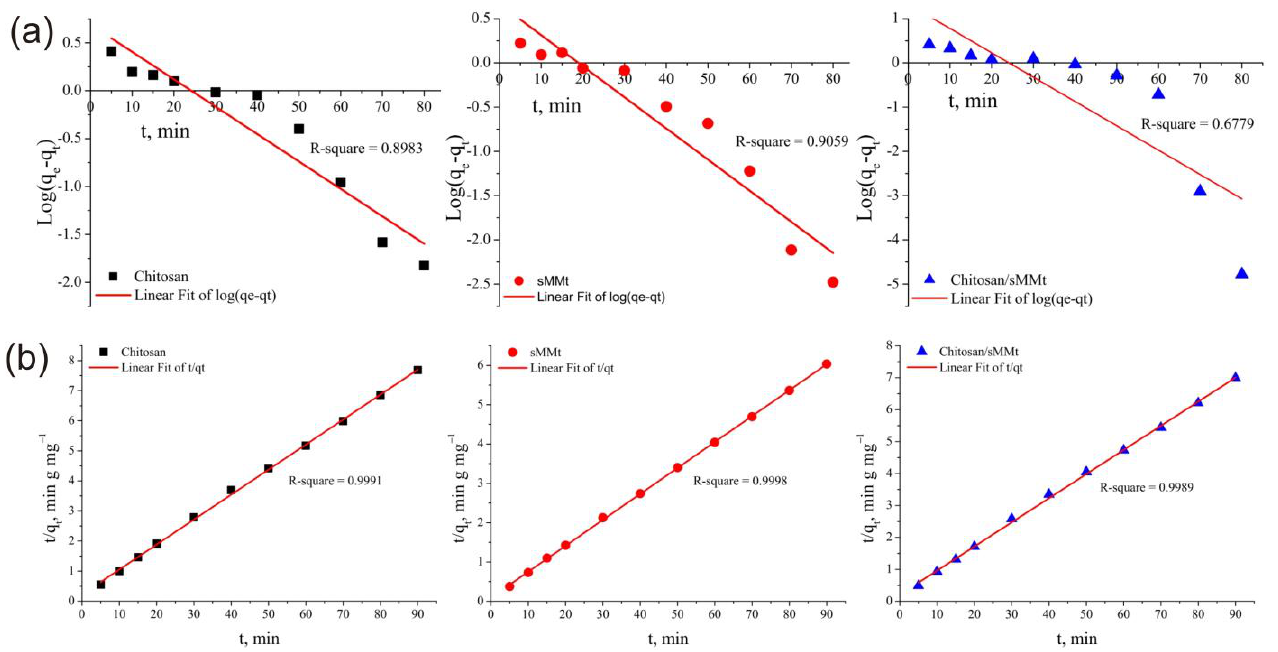
Fig. 9 (a) Lagergren and (b) pseudo-second order linear plots of chitosan, sMMt, and